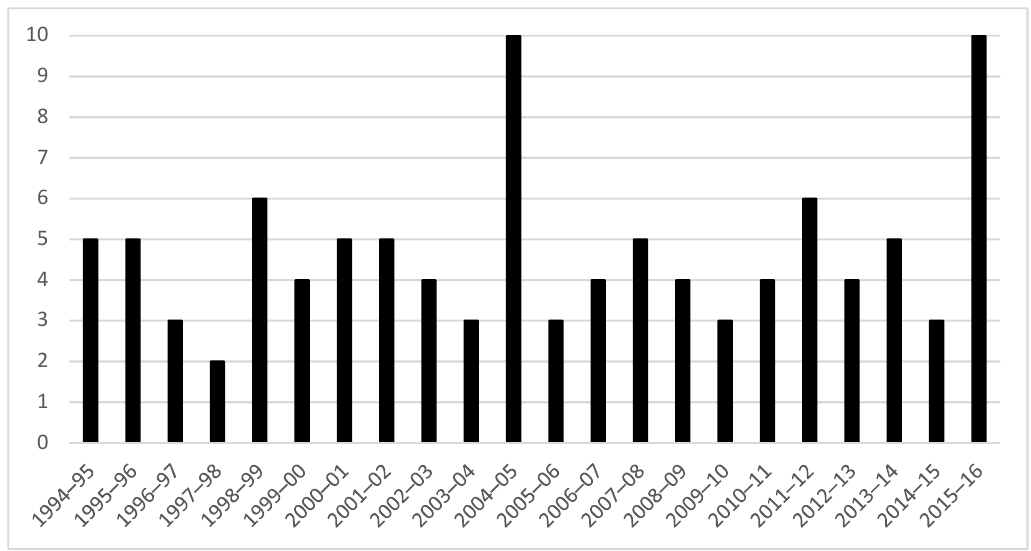
Figure 1. Number of teams with a leader change per season in Ligue 1 over the 1994–2016 period. 20 teams per season, except over the 1997–2002 period (18